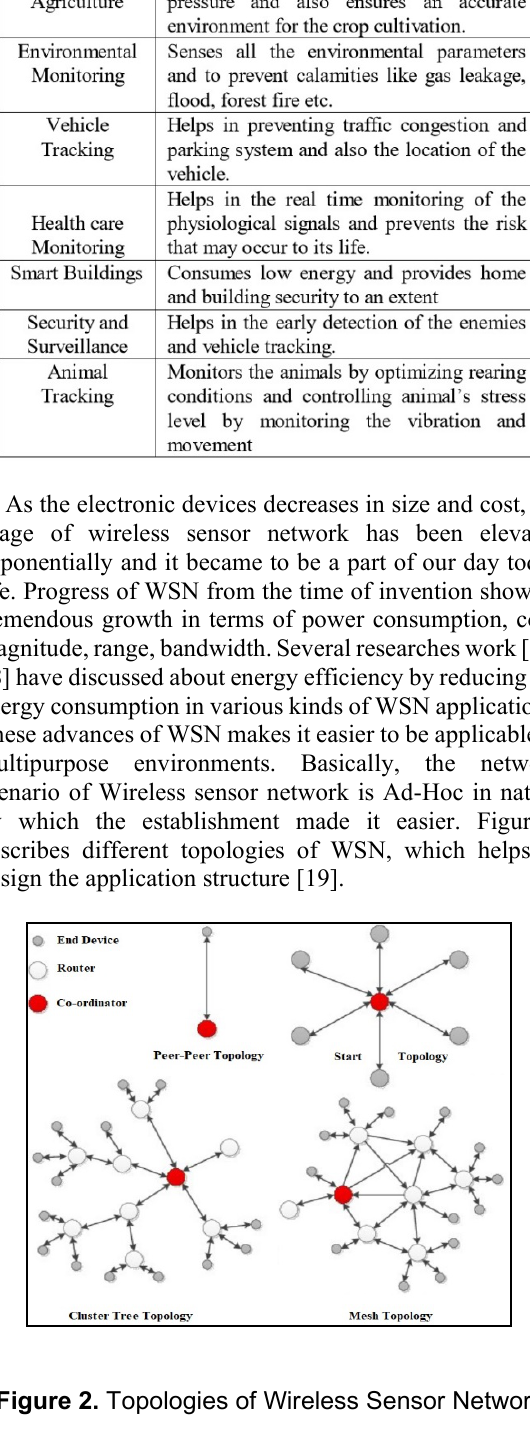
Figure 2. Topologies of Wireless Sensor